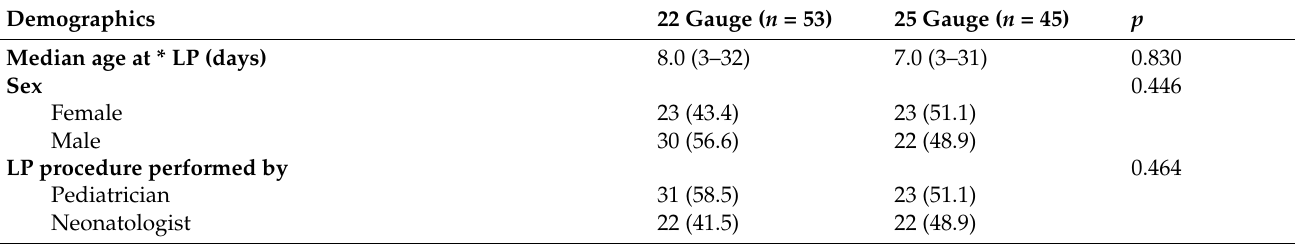
Table 2. Demographic and clinical characteristics according to pen-tip spinal needle gauges (22 G and 25